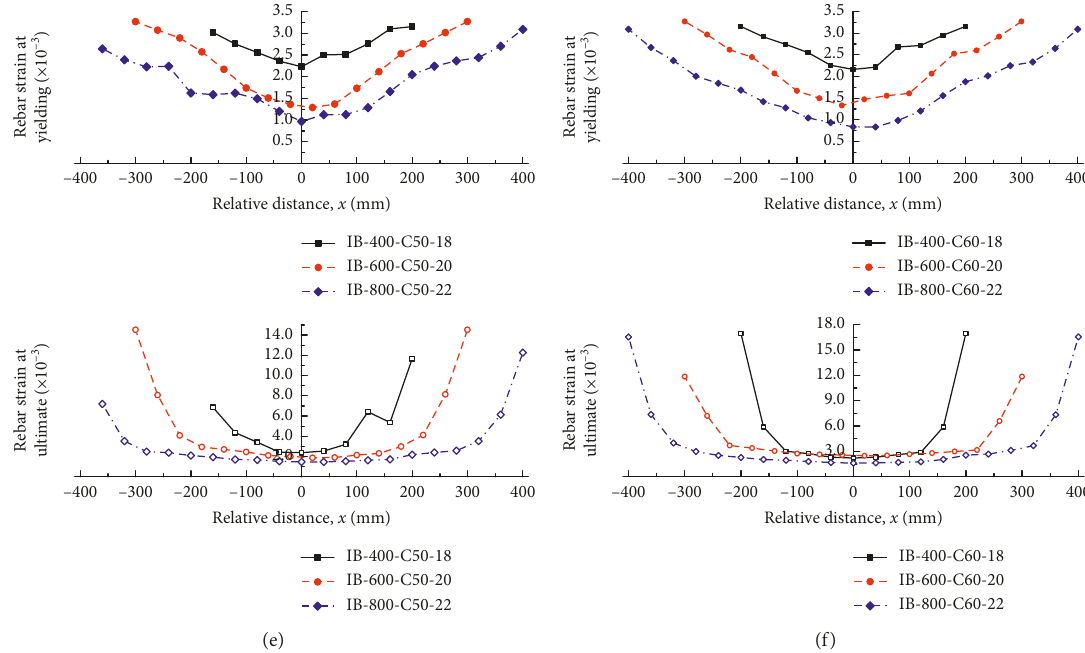
Figure 8: Strain distribution along the tensile reinforcement throughout the interior beam-column connection. Specimen type: (a) IA-C40; (b) IA-C50; (c) IA-C60; (d) IB-C40; (e) IB-C50; (f)